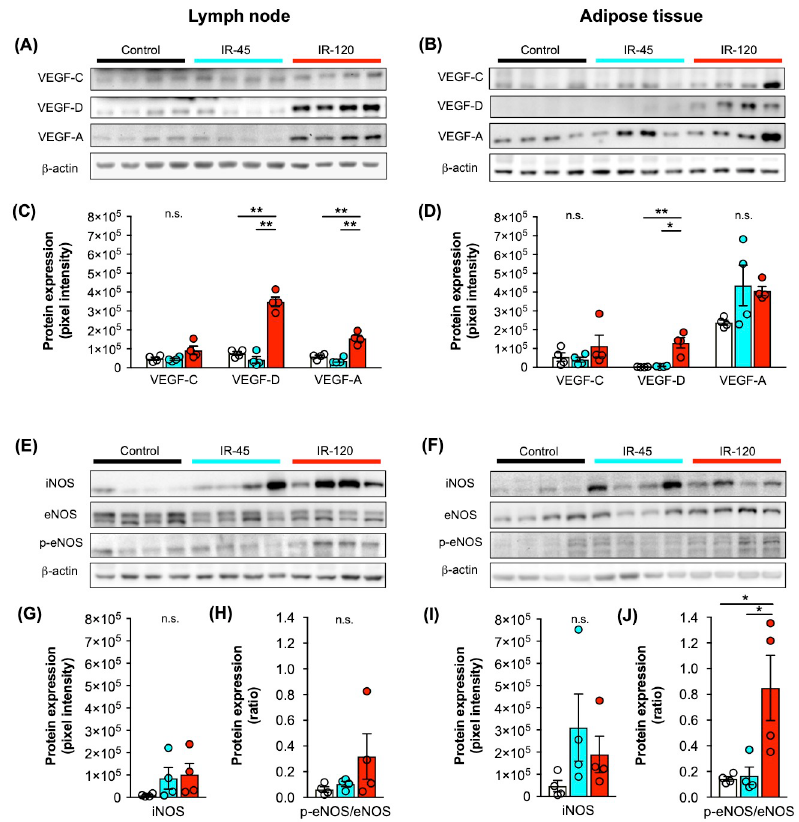
Fig 5. Growth factor and NOS expression of VLN flaps after IR injury. A-D Western blots ( A and B ) with quantification ( C and D ) of VEGF-C, VEGF-D and VEGF-A expression of control (white), IR-45 (cyan) and IR-120 (red) VLN flaps. Bands were cropped from different parts of the same gel. Panels A and C represent analyses of lymph nodes and panels B and D analyses of adipose tissue. Mean ± SEM, n = 4, � P < 0.05, �� P < 0.001, n.s. = not significant. E-J Western blots ( E and F ) with quantification of iNOS ( G and I ) and p-eNOS/eNOS ( H and J ) expression of control (white), IR-45 (cyan) and IR-120 (red) VLN flaps. Bands were cropped from different parts of the same gel. Panels E, G and H represent analyses of lymph nodes and panels F, I and J analyses of adipose tissue. Mean ± SEM, n = 4, � P < 0.05, n.s. = not significant. IR = ischemia/reperfusion, iNOS = inducible nitric oxide synthase (NOS), eNOS = endothelial NOS, p-eNOS = phospho-eNOS, VEGF = vascular endothelial growth factor, VLN = vascularized lymph